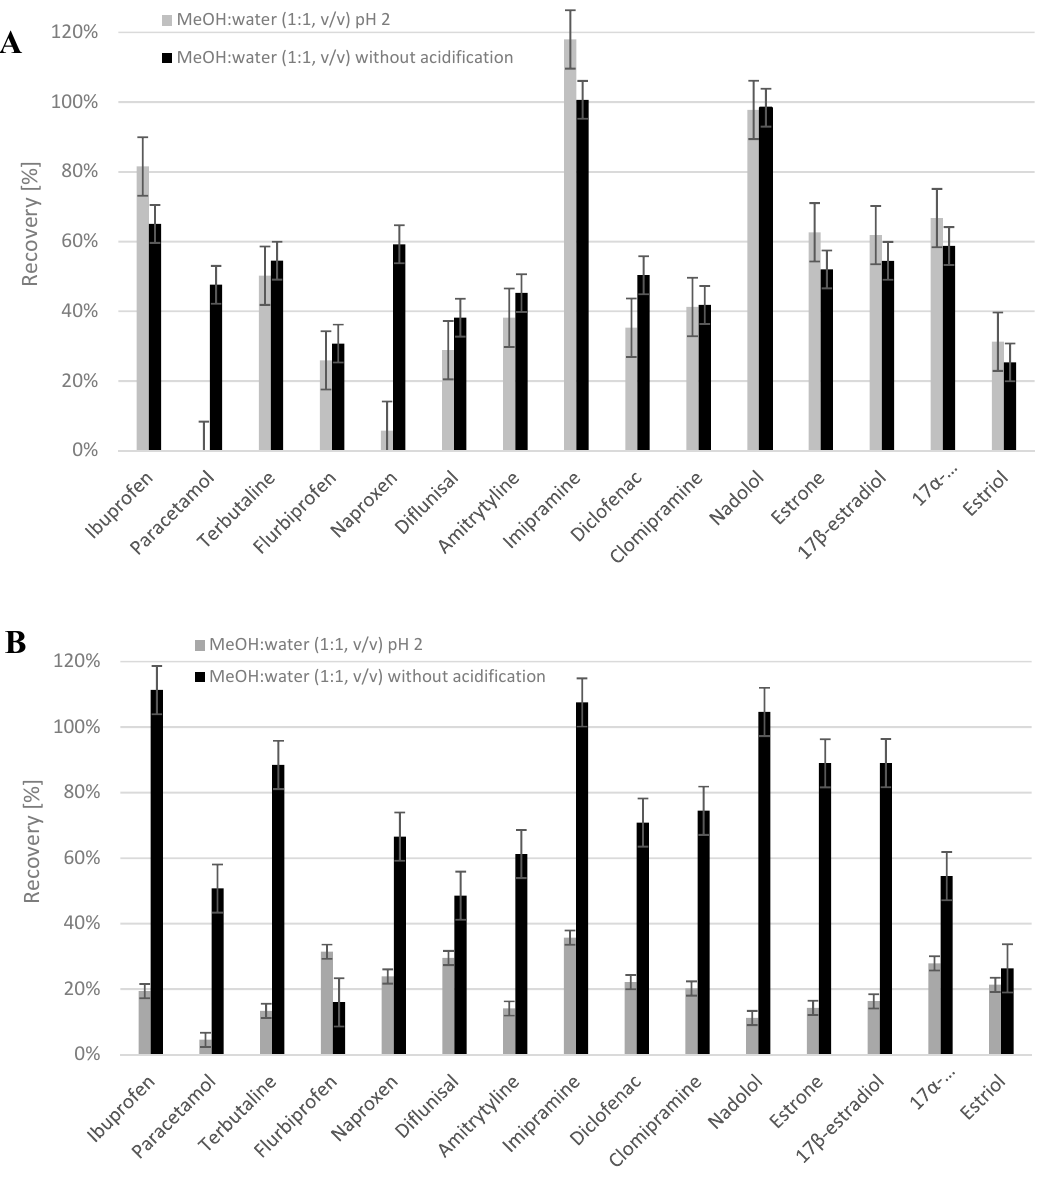
Figure 2. Impact of the acidification of ASE extracts prior to SPE purification on the recoveries of analytes, carried out at 80 °C ( A ) and 50 °C ( B ), respectively.